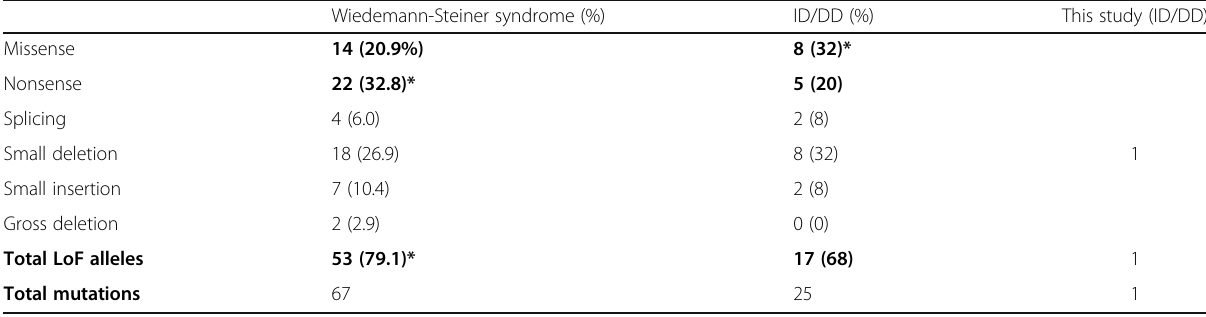
Table 1 Analysis of KMT2A mutations in Wiedemann-Steiner syndrome vs ID/DD Wiedemann-Steiner syndrome